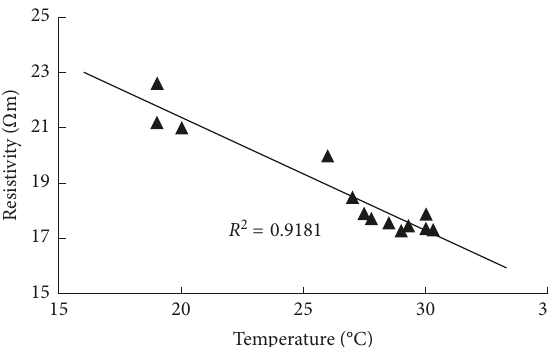
Figure 3: Soil resistivity acquisition instrument.